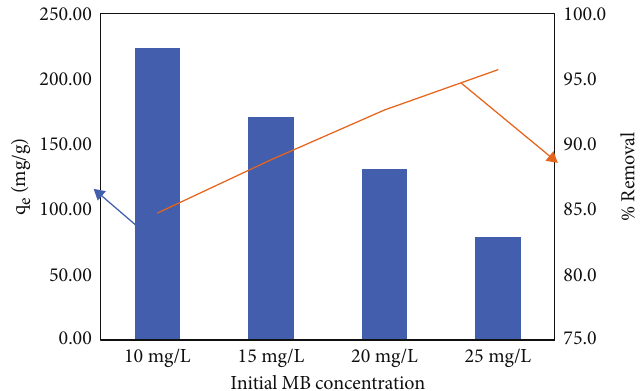
Figure 3: Initial MB concentrations a ff ect adsorption capacity and removal percentage.